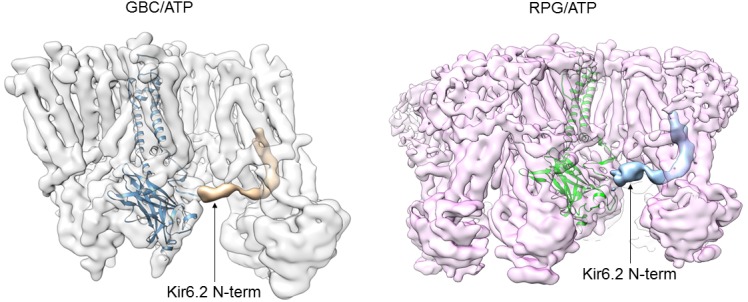
CryoEM density of Kir6.2 N-terminus in the GBC/ATP and RPG/ATP structures.Maps were sharpened and filtered to 6 Å. The Kir6.2 N-term density shown in gold in the GBC/ATP structure and in blue in the RPG/ATP structure was obtained by subtracting the map calculated from the structure, and then low-pass filtered to 6 Å.